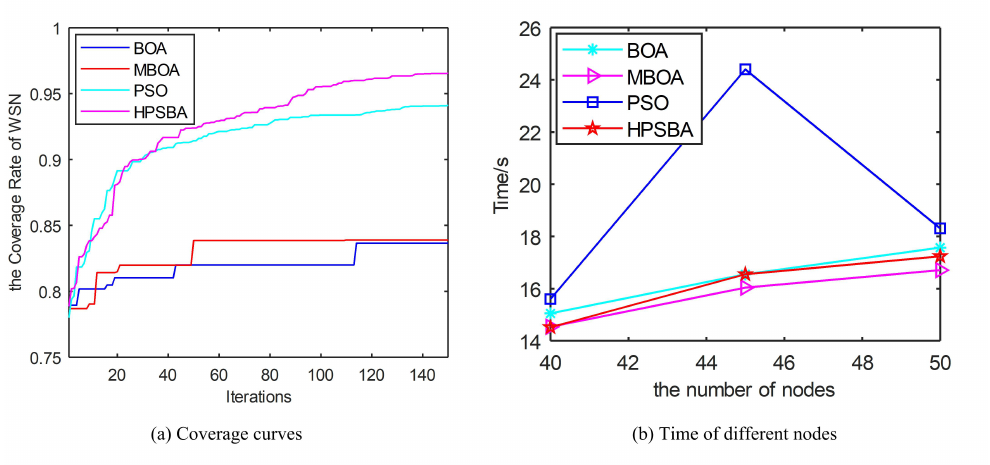
Figure 11. Coverage comparison curves and optimized coverage time.